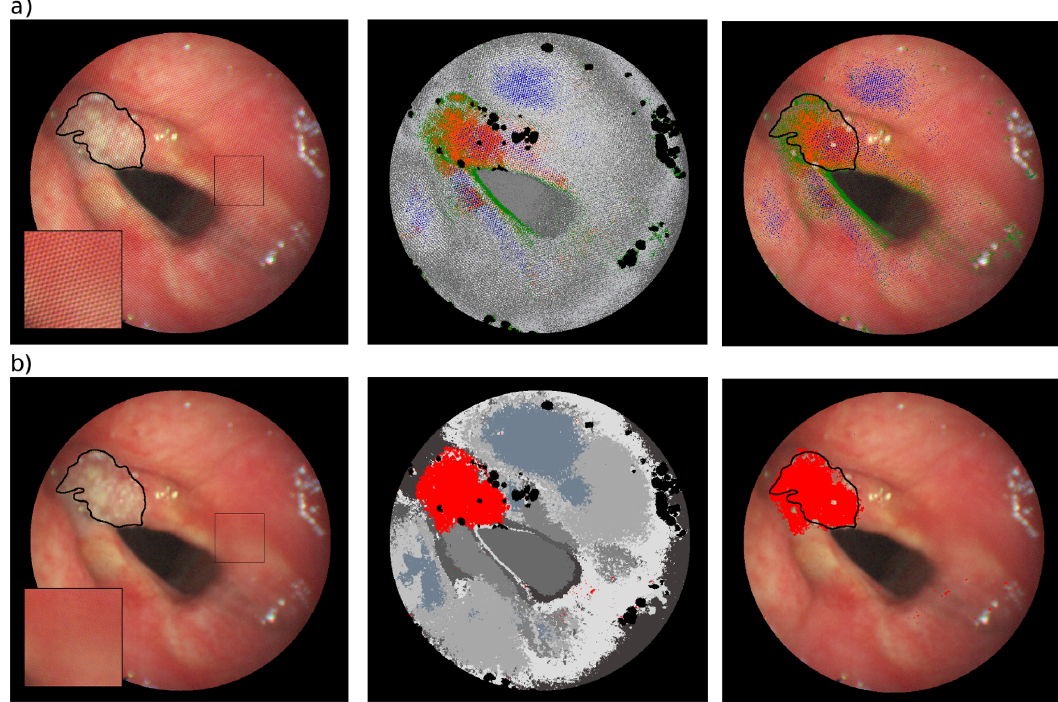
Figure 9. Unsupervised classification results for #caseA ( a ) before and ( b ) after pre-processing. Red Green Blue (RGB) image of the HS cube with cancerous tissue marked by a black line (left), unsupervised classification results with the cluster/clusters corresponding to a cancerous area marked in color (middle) and overlay of the cluster/clusters corresponding to the cancerous area and the RGB image (right).